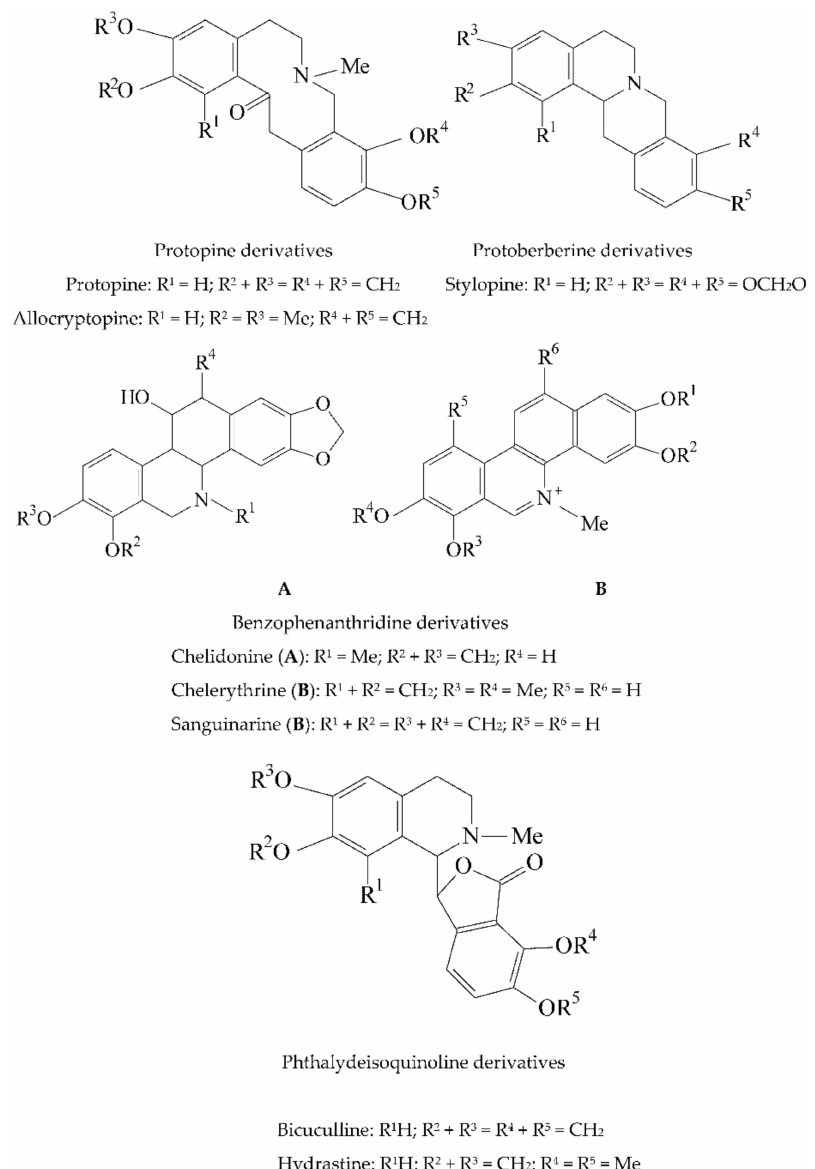
Figure 1. Structures of alkaloids that can be found in the composition of F. schleicheri species